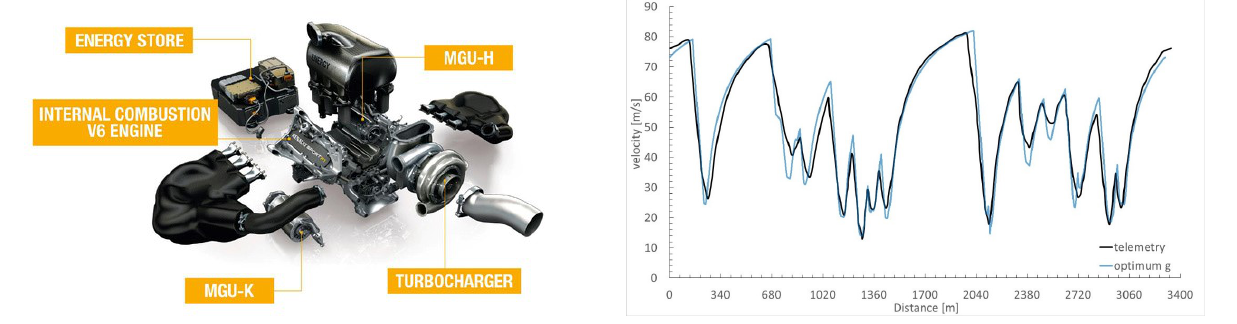
Velocity of a F1 car covering a 1.15.100 lap in Monte Carlo